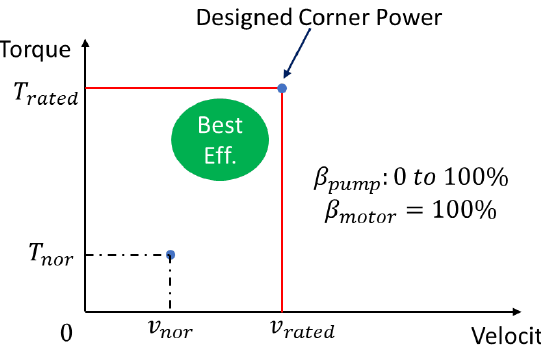
Figure 2. Reference HT System Operation Condition.